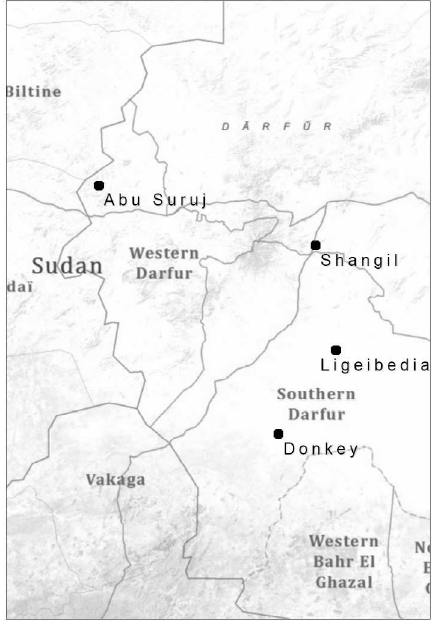
Figure 1. Investigation areas. Source: own representation based on Bing Maps (Copyright © 2009 Microsoft Corporation).